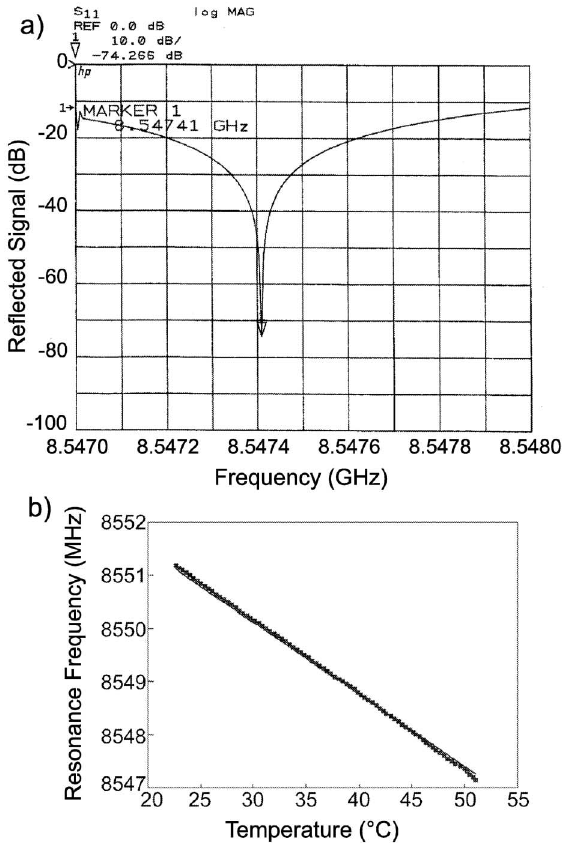
splitting the incident power from the PDRO with a tee [Fig. 4(b)]: the power on each arm is first balanced with a precision attenuator, and the mixer response is measured as a function of the phase shifter settings, as shown in Fig. 5.